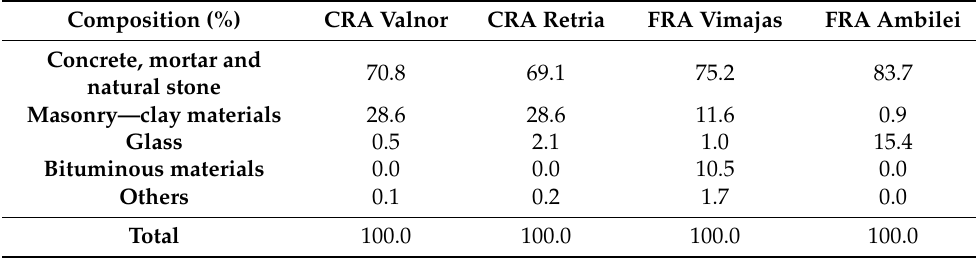
Table 1. Composition of the recycled aggregates (% in mass) .